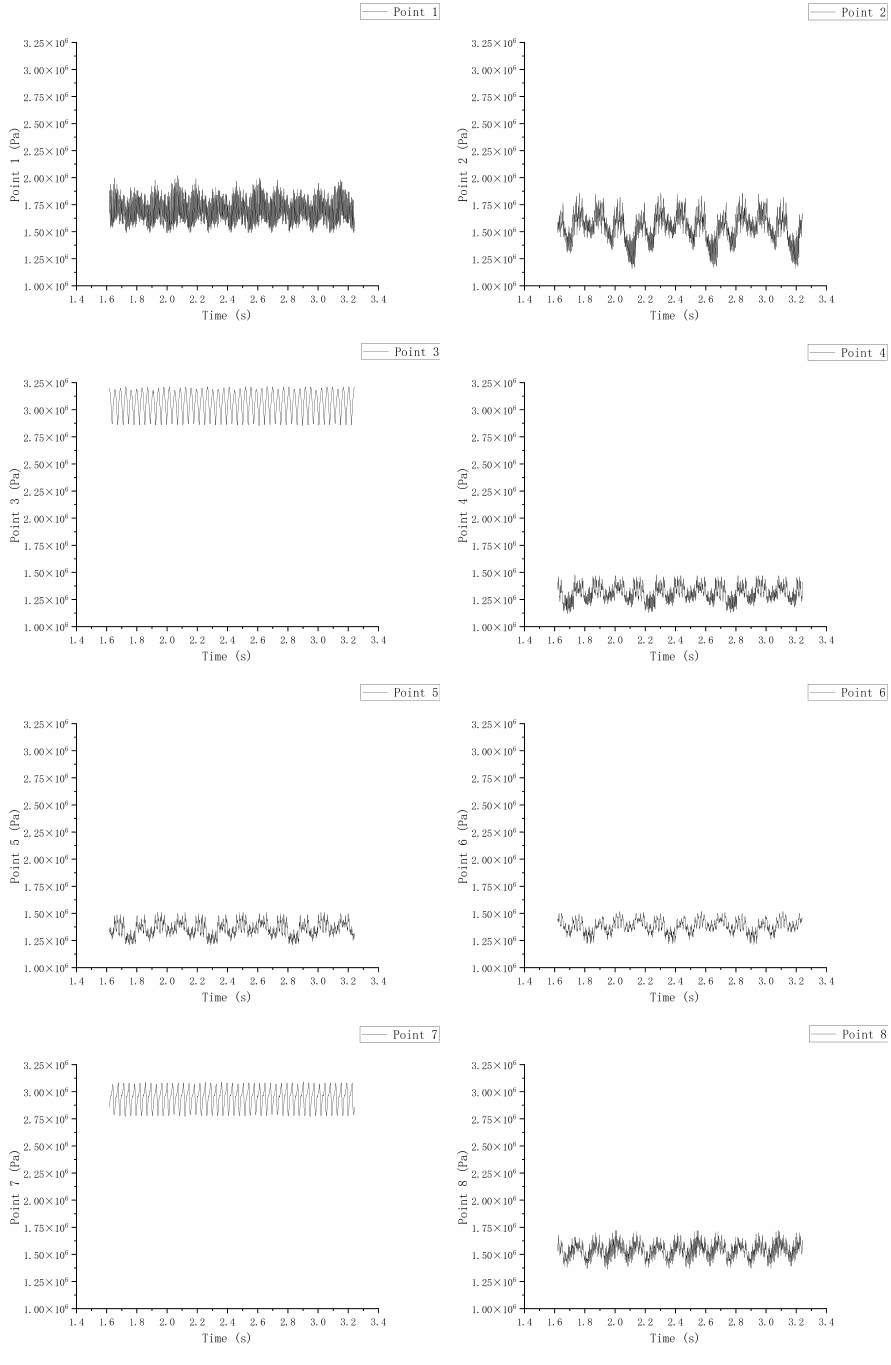
Figure 25. The pressure distributions of the upper bottom ring